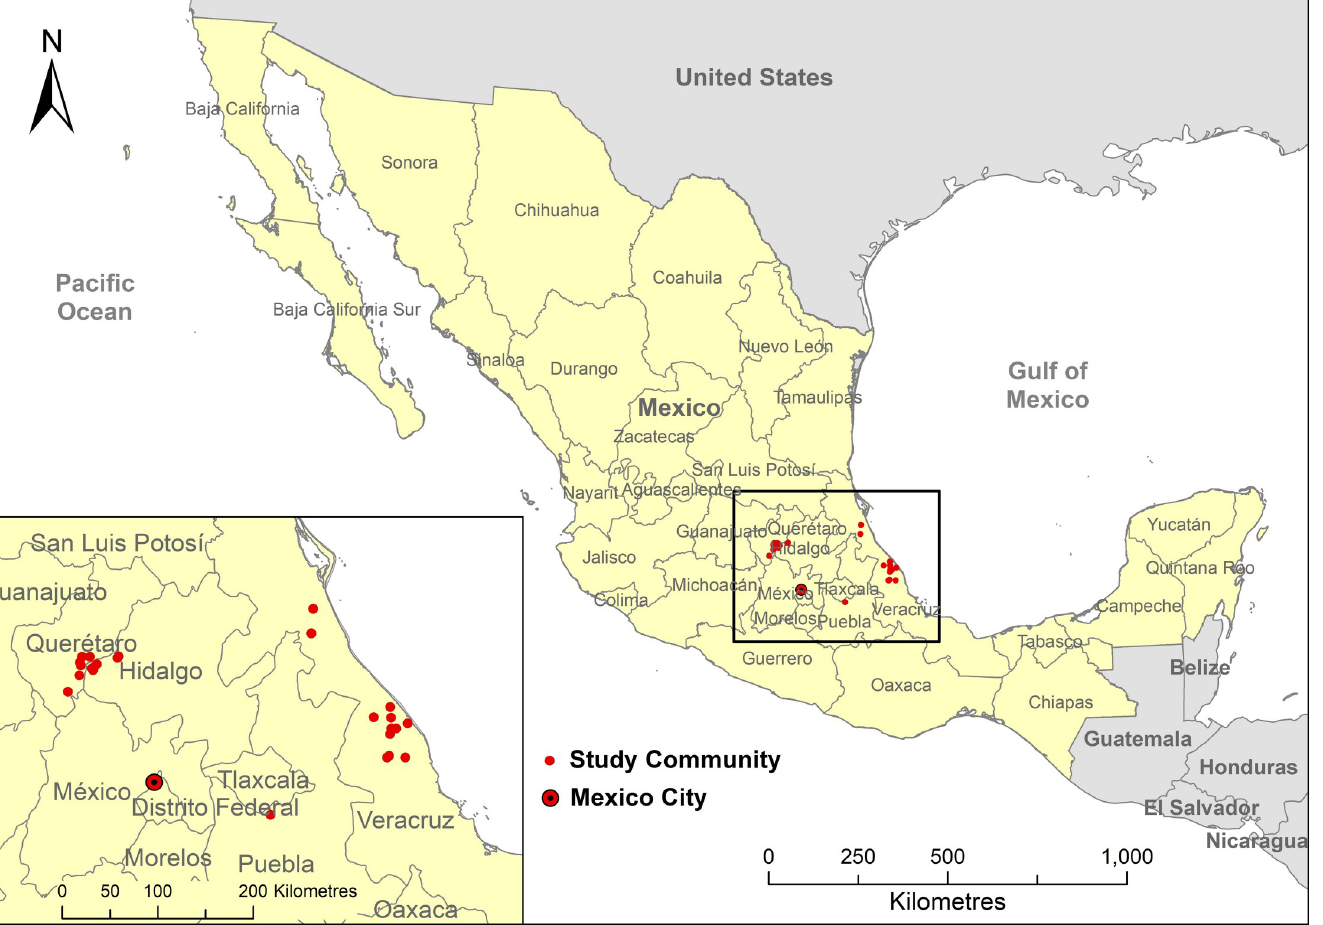
Fig 1. Map showing the location of the study communities within Mexico. Country data source: Diva-GIS.